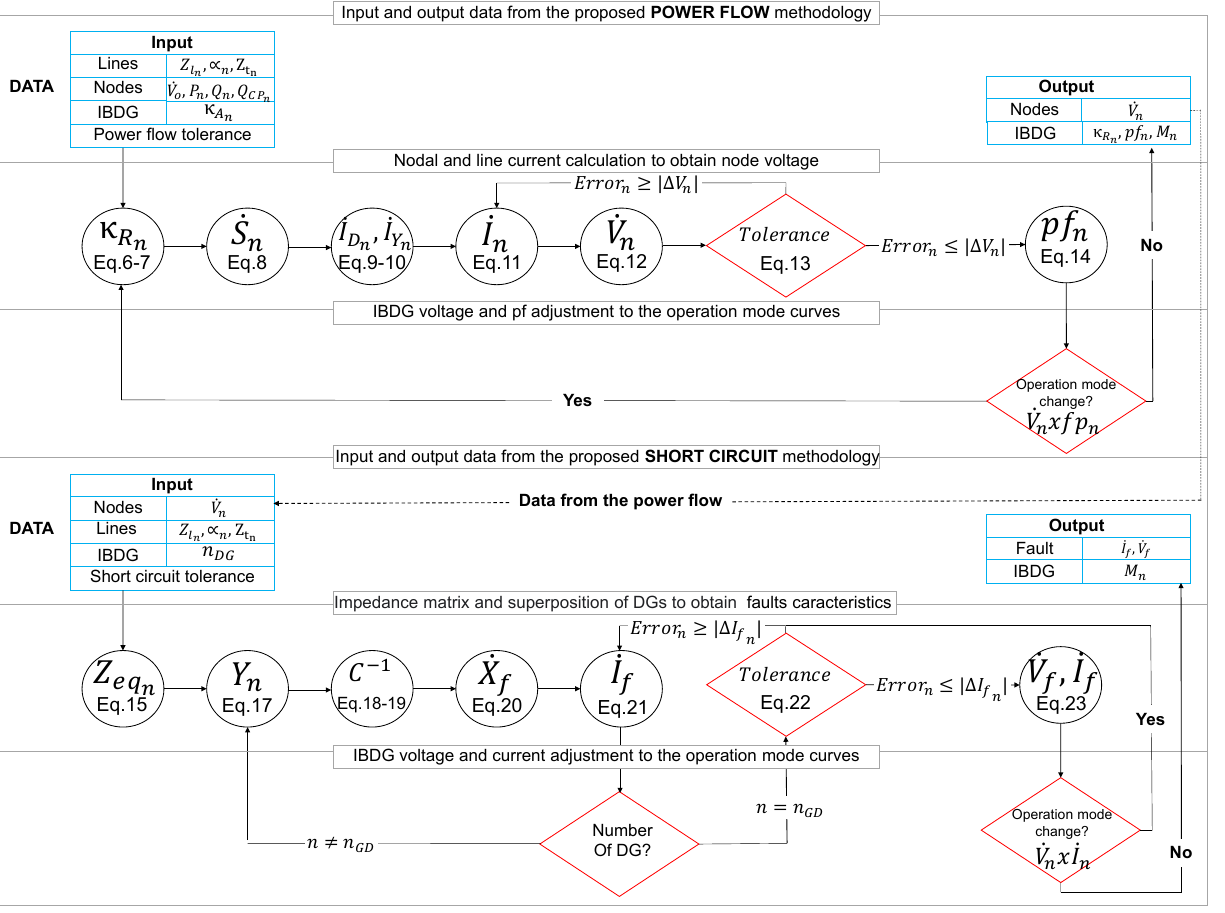
Figure 5. Power flow and short-circuit calculation flowchart with IBDG inverter curve